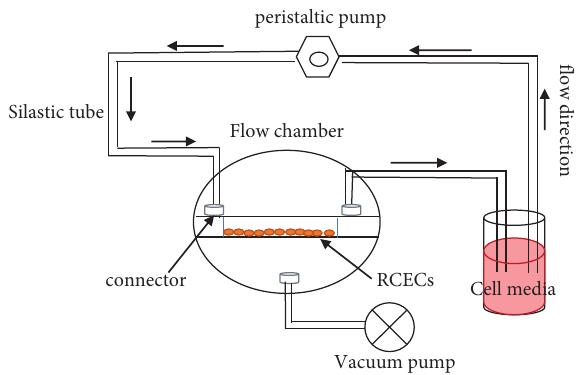
Figure 1: Diagram of the flow circuit system. The flow circuit included a parallel plate flow chamber, a peristaltic pump, a vacuum pump, and a medium reservoir, and these components were connected by silicone tubes and